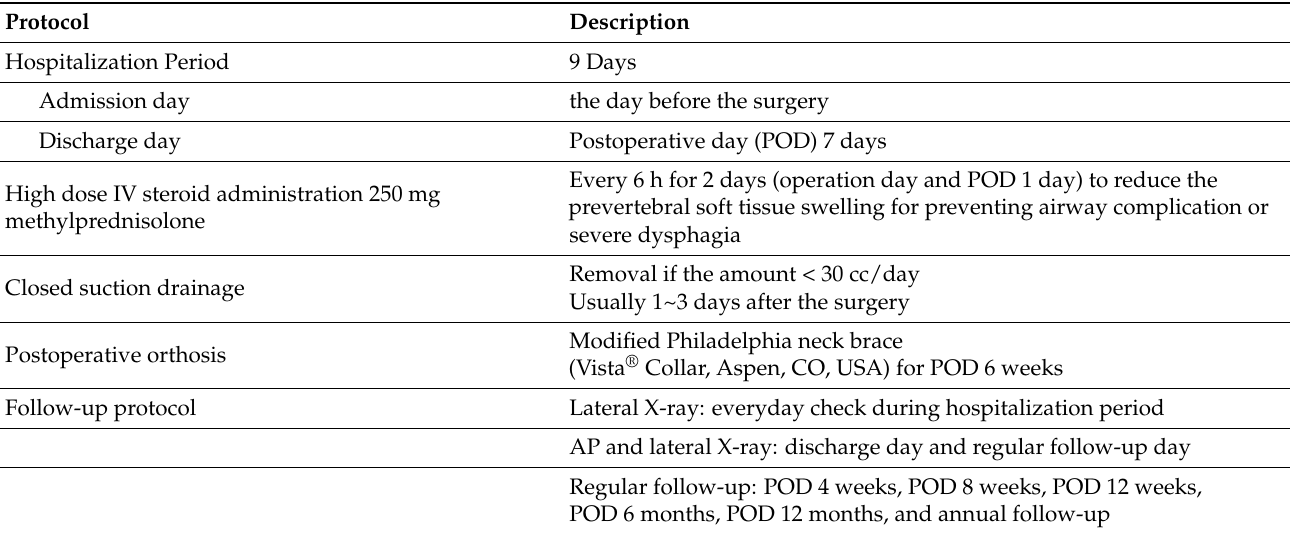
Table 1. JBNU anterior cervical spine surgery